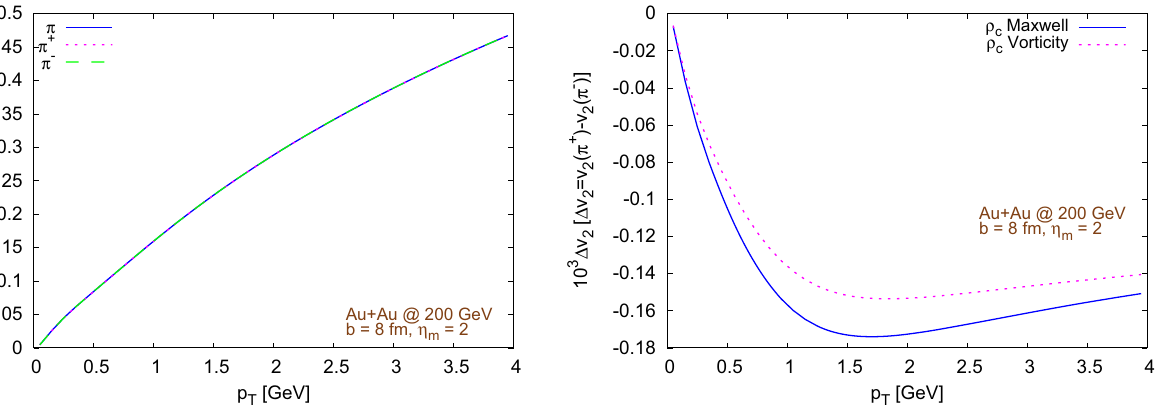
Fig. 12 Evaluation the effects of a charge dependent freezeout (see App. H) on the elliptic flow of pions. Left: v 2 ( p T , y = 0 ) for pions without considering their electric charge and for positive and negative pions. Right: Difference between v 2 ( p T , y = 0 ) of positive and nega-